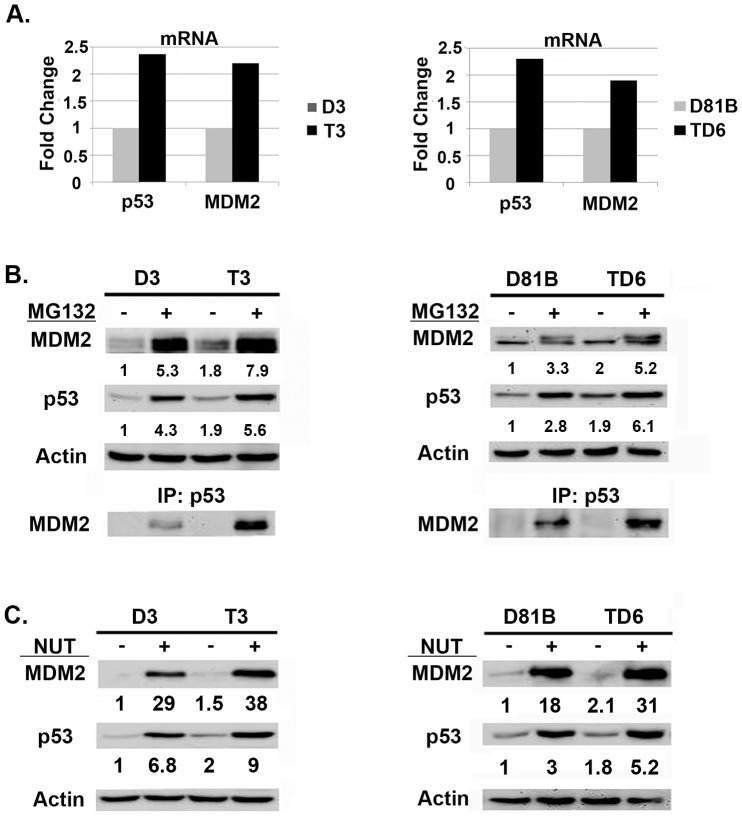
Tetraploid clones express more p53-MDM2 complexes and more p53 after Nutlin treatment than diploid counterparts.
A) P53 and MDM2 mRNA levels were compared in untreated tetraploid clones (T3, TD6) and their diploid counterparts (D3, D81B). B) Diploid (D3, D81B) and tetraploid (T3, TD6) clones were untreated or treated with proteasome inhibitor MG132 (10 µM) for 8 hrs. Upper Levels of MDM2, p53, and actin (loading control) in untreated and MG132 treated cells are shown. Lower To determine levels of p53-MDM2 complexes in diploid and tetraploid cells, protein lysates were immunoprecipitated with anti-p53 antibody, followed by immunoblotting for MDM2. C) Diploid (D3, D81B) and tetraploid (T3, TD6) clones were untreated or treated with Nutlin (10 µM) for 24 hrs. p53 and MDM2 protein levels were detected by immunoblotting and quantified using Image-J software. The relative amount of p53 and MDM2 protein in the untreated diploid clones was given a value of “1.0”. Numbers indicate the relative level of each protein. Actin was used as a loading control.